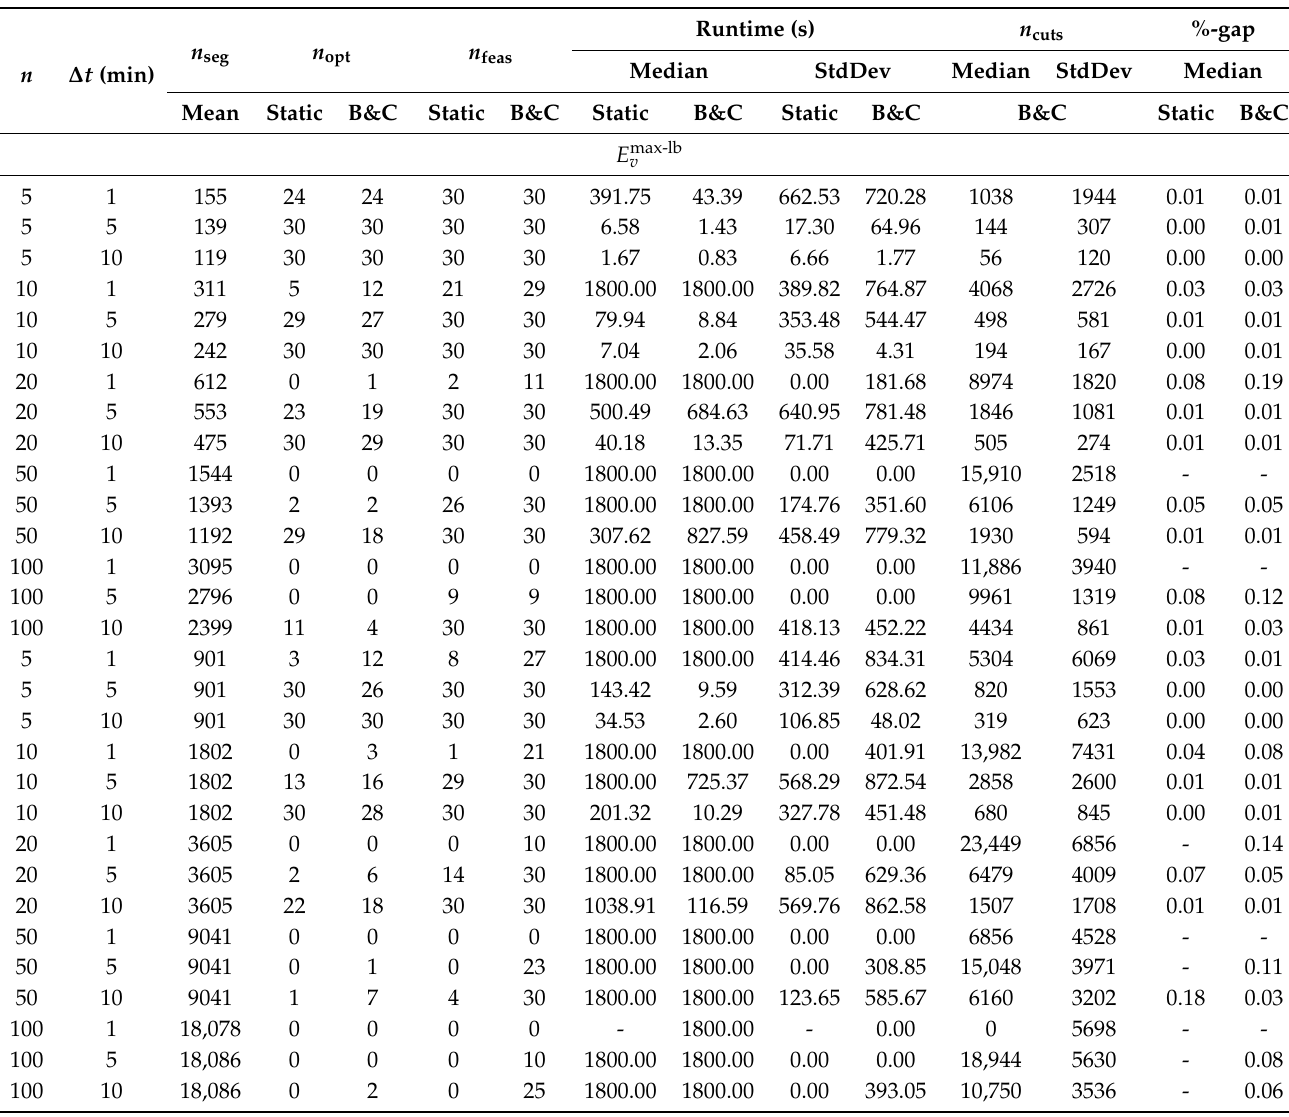
Table A1. EVS-SOC-GLIN results for solving the static model versus B&C with E max-lb v and E max-ex v based on the original P max v functions and P gridmax = 10 n